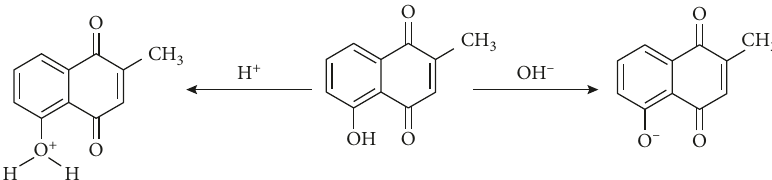
Scheme 1: Effects of pH changes on the plumbagin